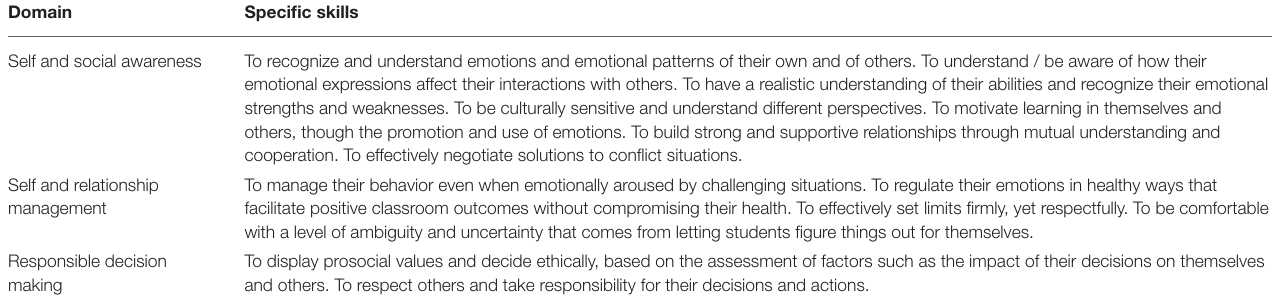
TABLE 2 | Description of teacher-specific social, emotional, and cognitive skills within each SEC [retrieved from Jennings and Greenberg (2009), p. 495].